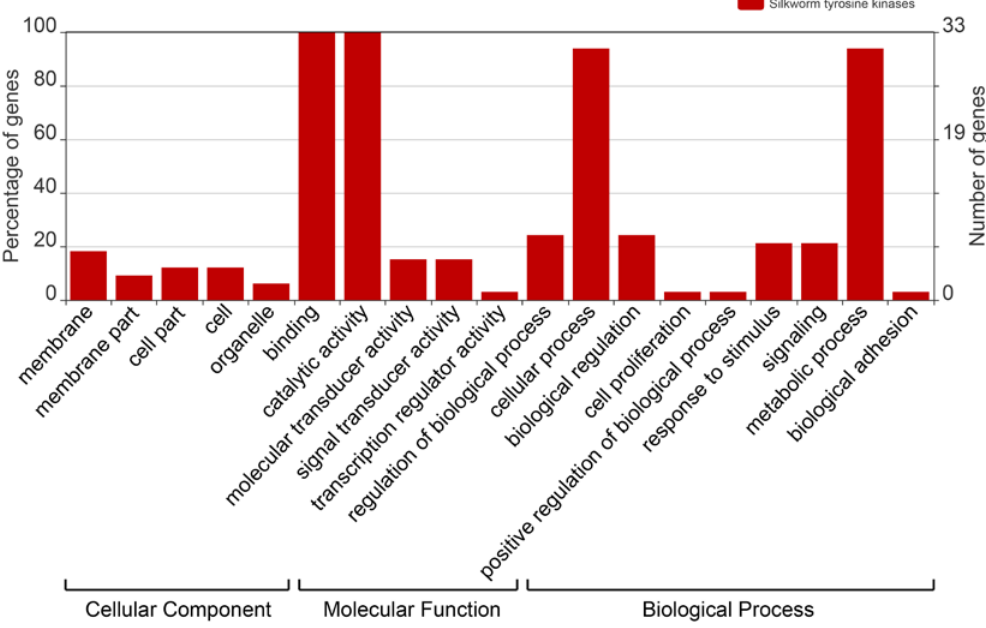
Figure 3. Gene Ontology (GO) categories of BmTK genes. This analysis was visualized with an online tool, WEGO (Available online: http://wego.genomics.org.cn/).